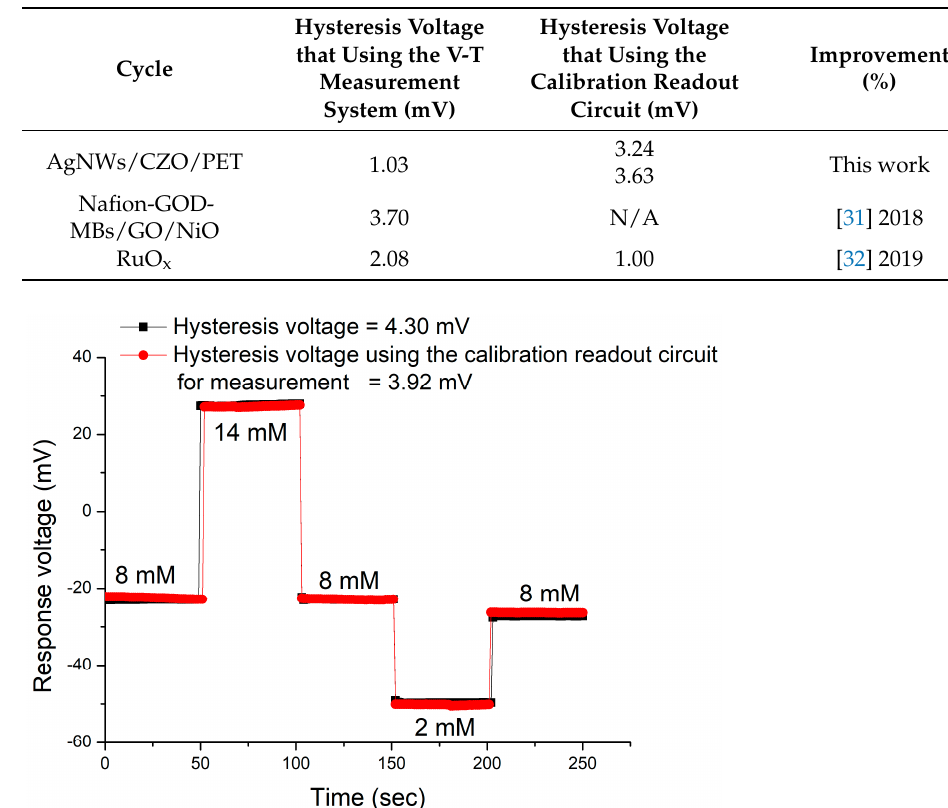
Table 4. Values of the non-ideal effects based on different sensors.